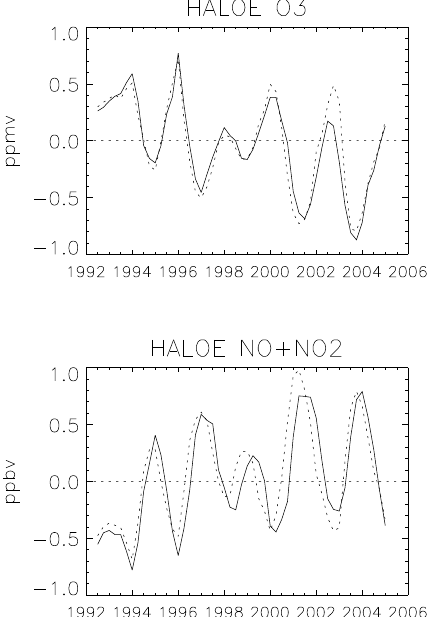
Figure 8. Annual median HALOE O 3 (top) and NO + NO 2 (bot- tom) anomalies at 10hPa from 5 ◦ S to 5 ◦ N. Annual anomalies are shown four times per year; hence, each measurement is included in four data points. Results are shown separately for sunrise (solid) and sunset (dashed). Sunset NO + NO 2 anomalies have been multiplied by 0.4 so that they fit on the same scale as the sunrise anomalies.